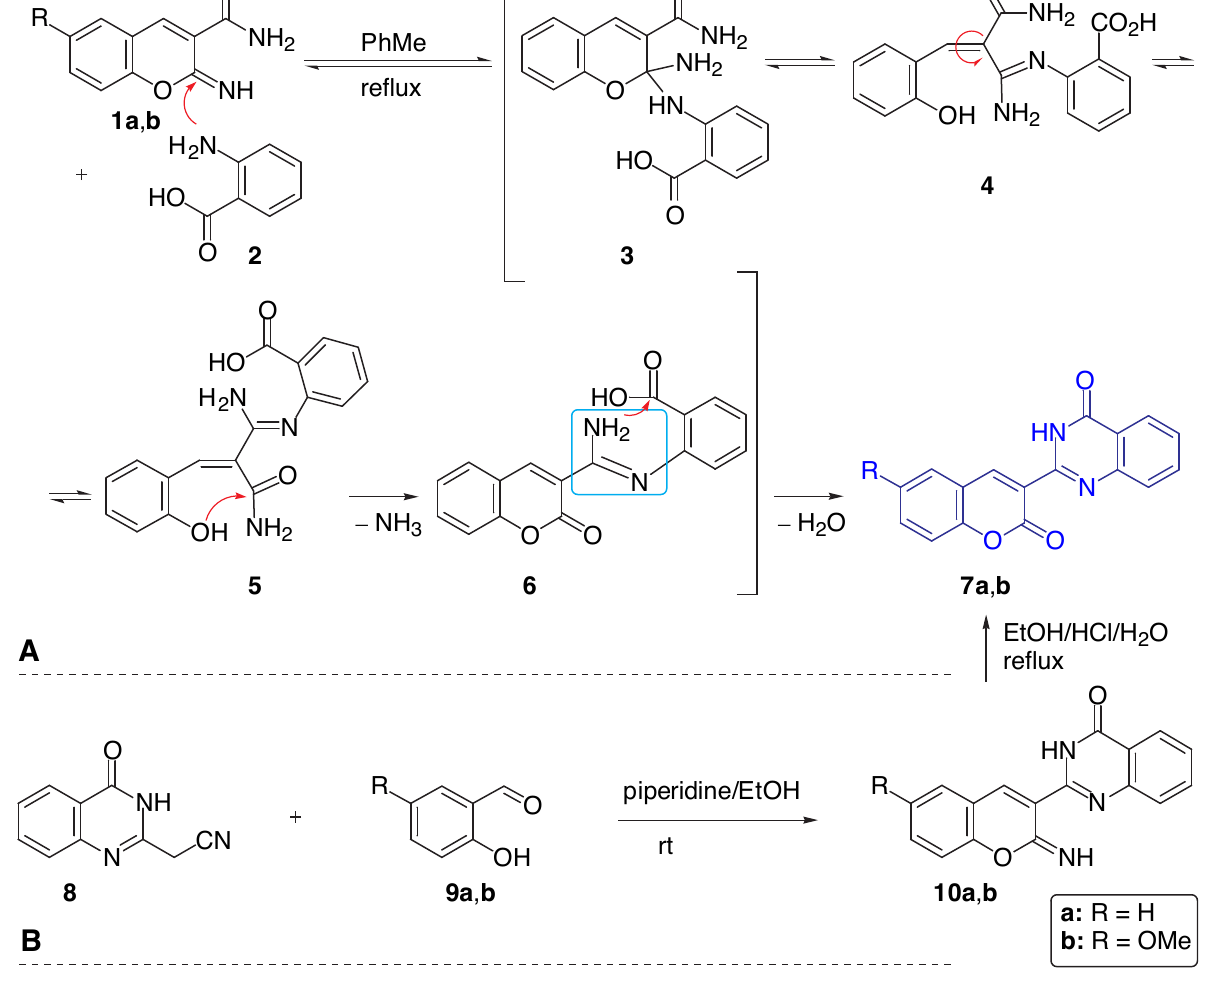
Scheme 1 . Proposed mechanism for the transformations of 2-imino-2 H -chromenes 1 into 3- (quinazolin-2-yl)-2 H -chromen-2-ones 7 by the action of anthranilic acid ( 2 ) under